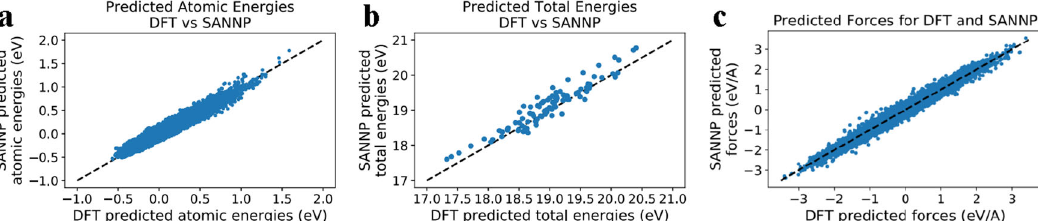
Fig. 5 Validation of the accuracy of machine learning potentials. The intuitive linear correlations between the predicted a atomic energies, b total energies, c atomic forces and those calculated by DFT in the testing set for the amorphous silicon. Reproduced with permission from ref. 67